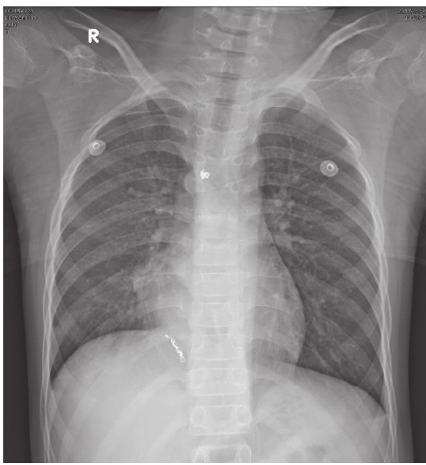
Figure 7: One day after bronchoscopy, no evidence of atelectasis was found on the chest